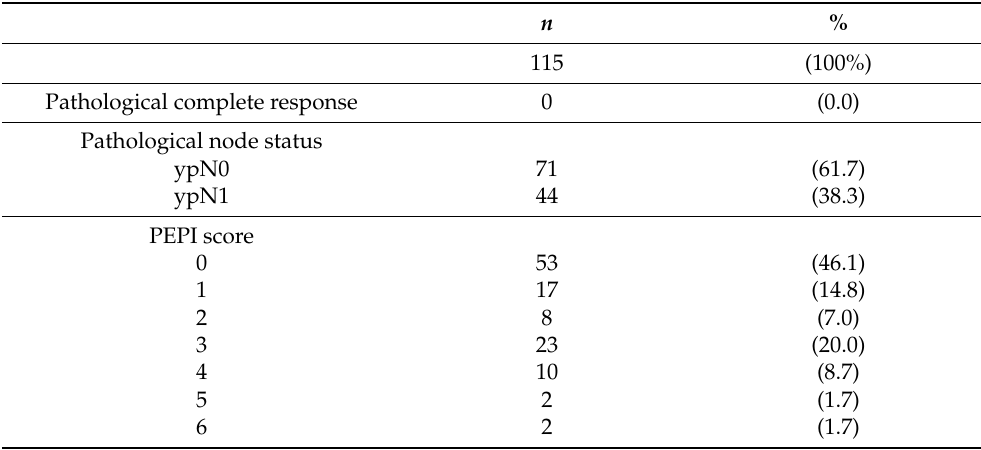
Table 2. Pathological outcomes after NET.